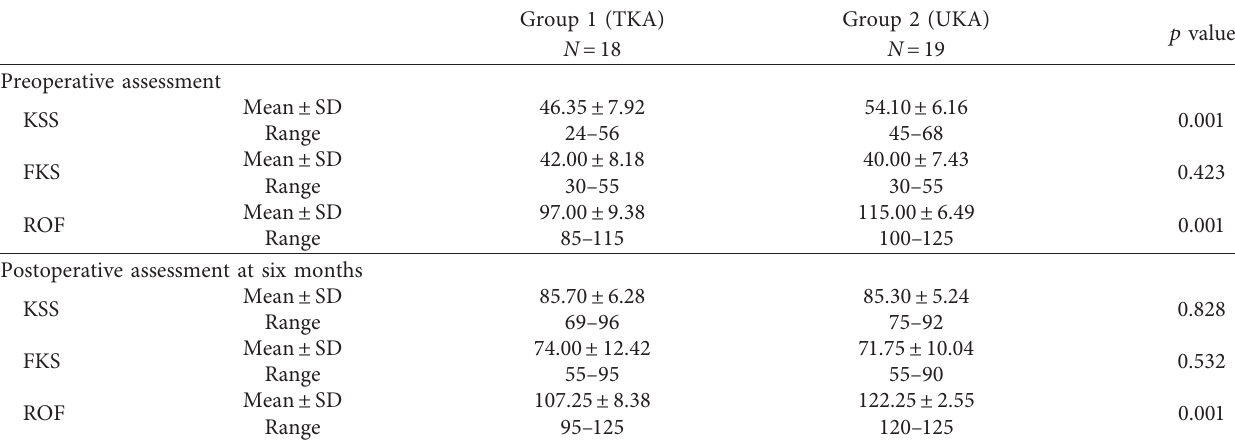
Figure 5: Preoperative and postoperative radiological assessment of two left knees of two female patients who undergone TKA (a) and UKA (b). Both patients had perfect operations with no complications. Table 2: Comparison between TKA and UKA groups, preoperatively and